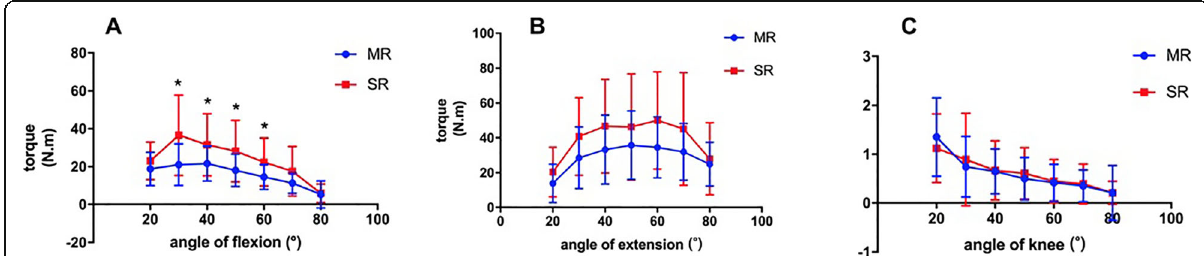
Fig. 2 Comparison of angle specific torque at 180°/s: a extension; b flexion; c H/Q ratio. * indicated P < 0.05 between groups. (SR: single radius, MR: multiple radius, H/Q: hamstring/quadriceps)